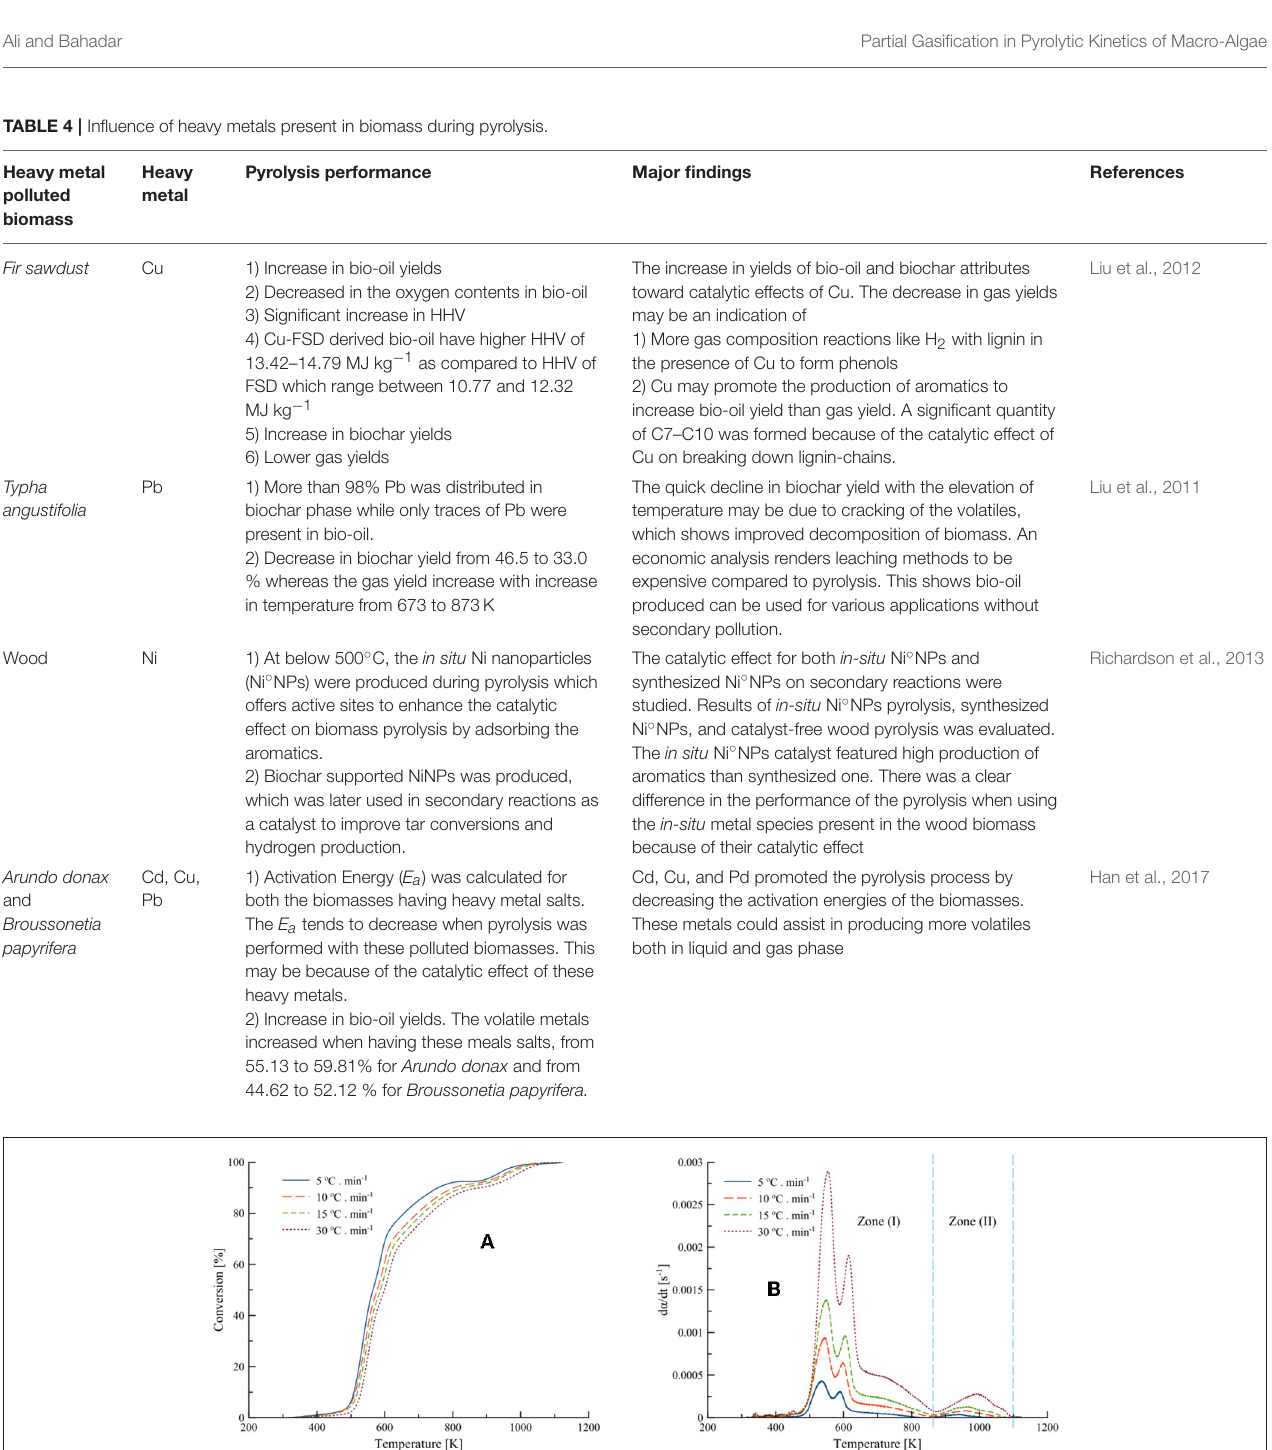
weight loss rate and increase the gases produced (like CH 4 , H 2, and CO 2 ) from the pyrolysis of T. ornata and could remove lattice oxygen from the oxygen carriers. Depending upon the amount of inorganics accumulated by the marine algae T. ornata , the catalytic characteristics of heavy metals stimulating pyrolysis and partial gasification could